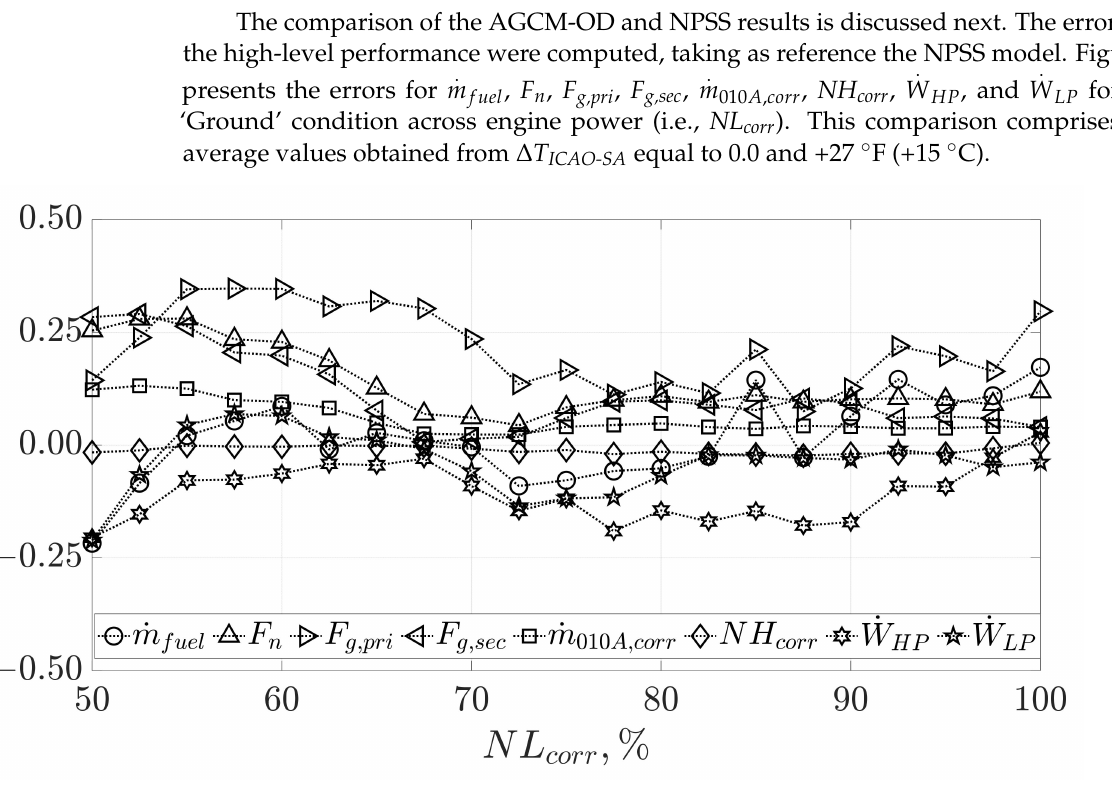
Figure 4. Average errors ( ∆ T ICAO-SA = 0.0 and +27 ◦ F/+15 ◦ C) vs. NL corr (‘Ground’